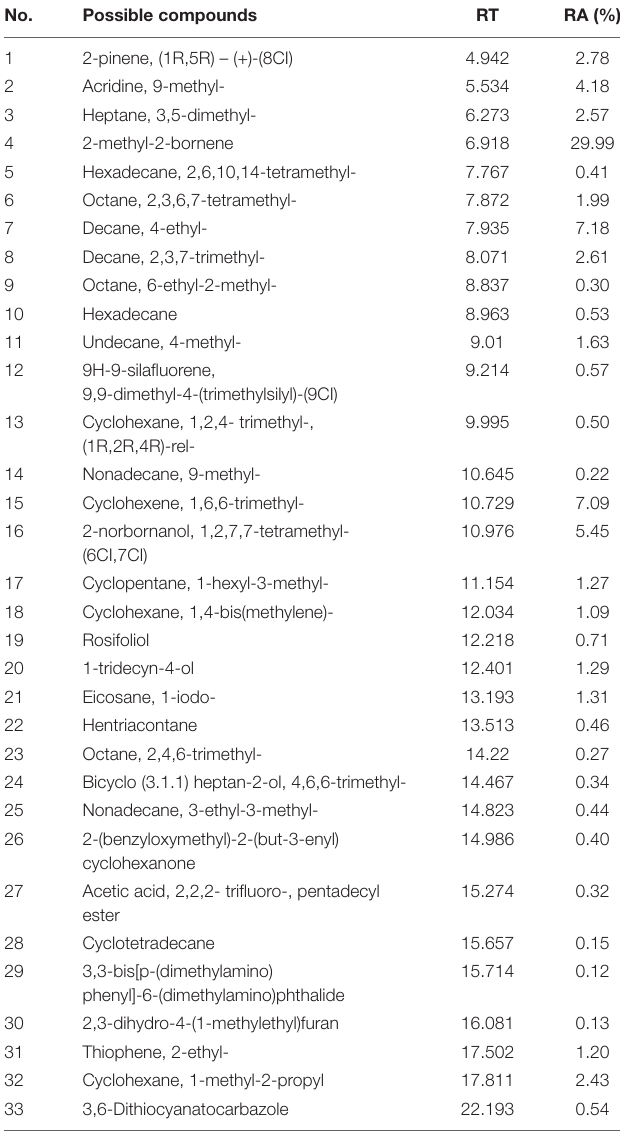
TABLE 5 | Possible VOCs from HN6 using the area normalization method by SPME-GC-MS analysis.